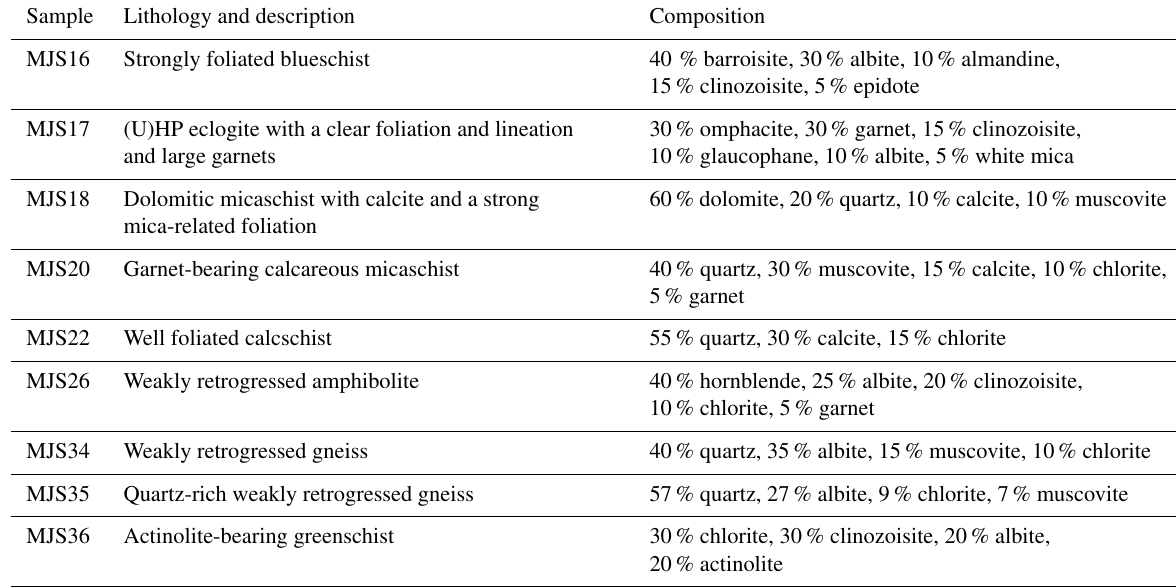
Table 1. Description and modal composition of investigated